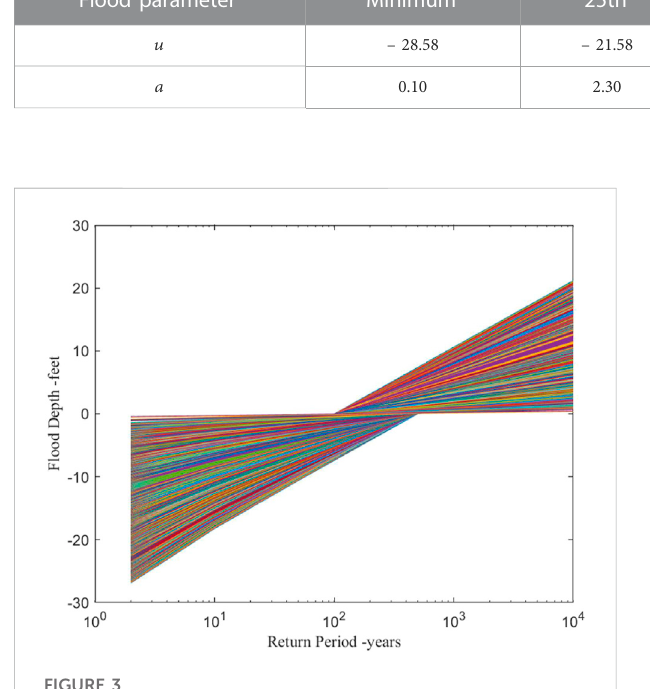
FIGURE 3 Flood depth-return period relationship for synthetic